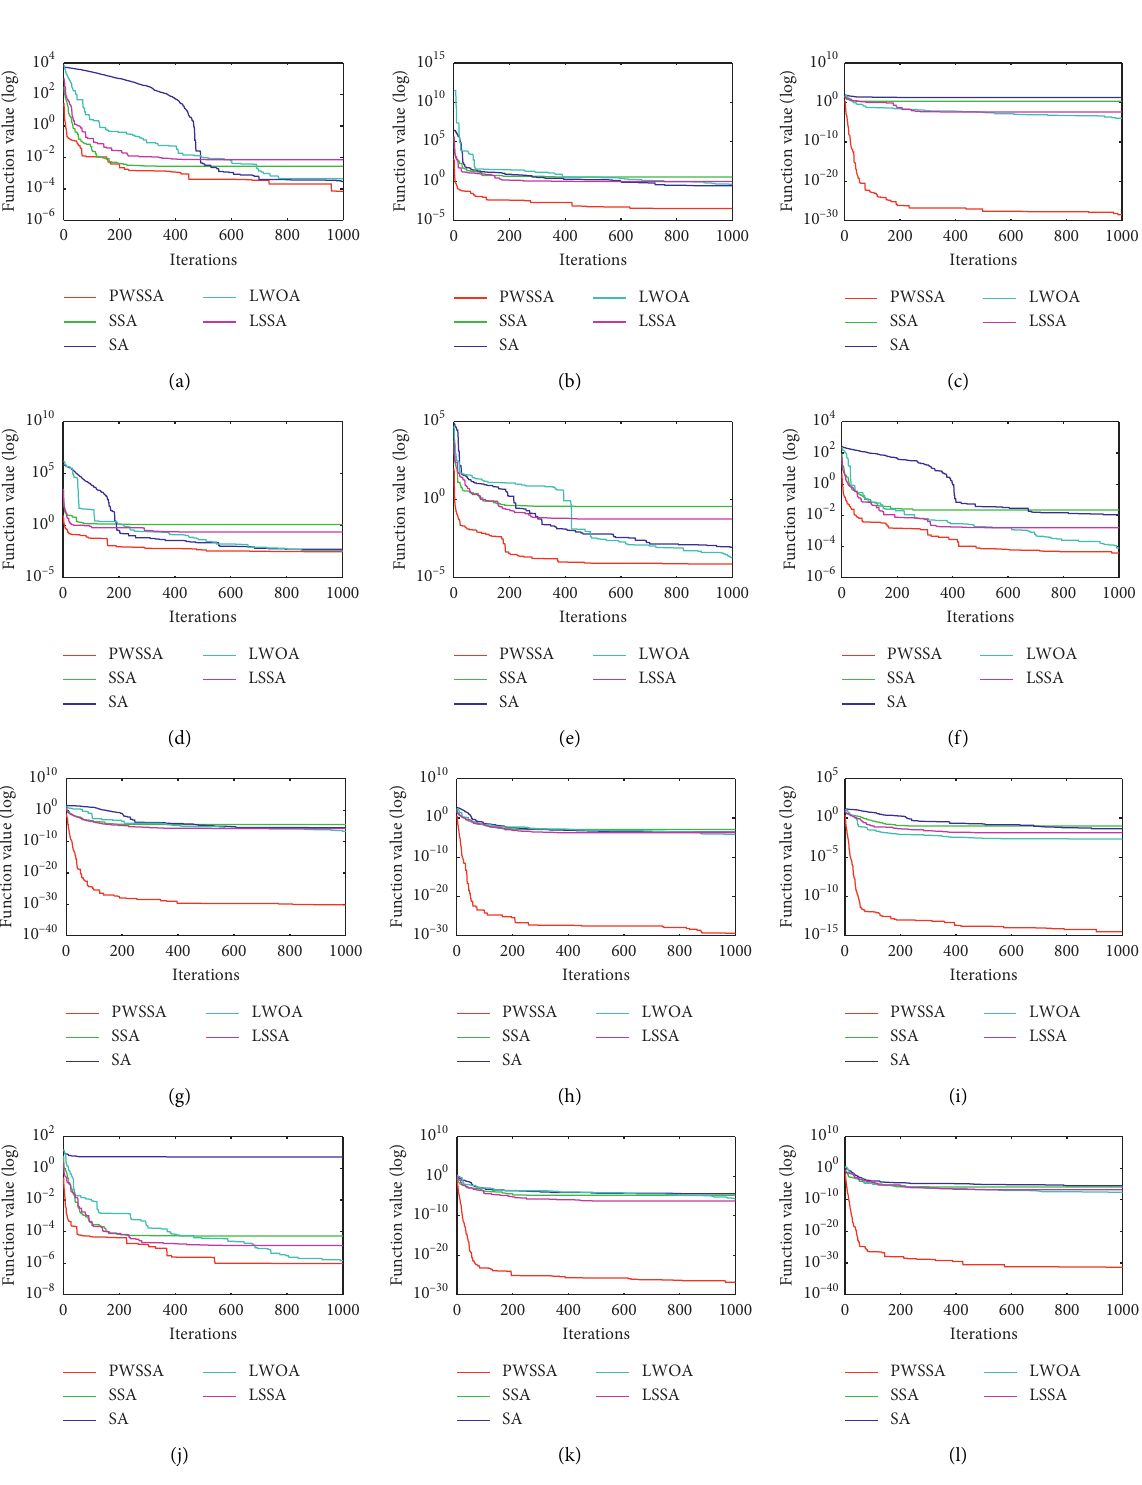
1 . (b) f 2 . (c) f 3 . (d) f 4 . (e) f 5 . (f) f 6 . (g) f 7 . (h) f 8 . (i) f 9( D � 2) . (j) f 10( D � 2) . (k) f 11( D � 2) . (l)